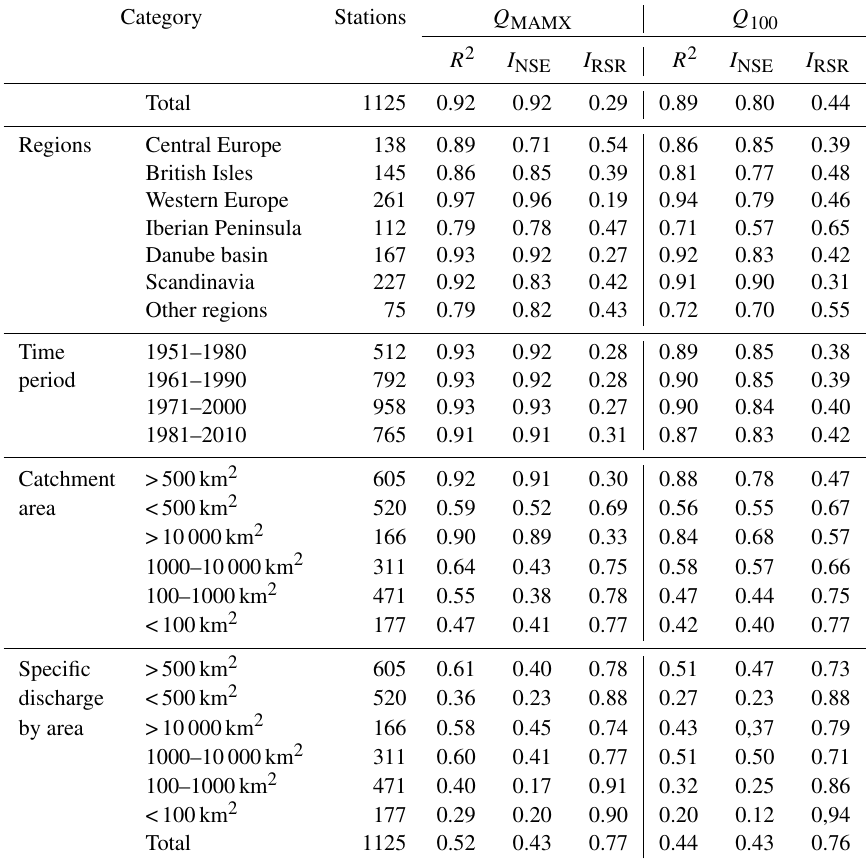
Table 2. Validation results for simulated and observed average annual maxima of daily river discharges Q MAMX and annual maxima with a 100-year return period Q 100